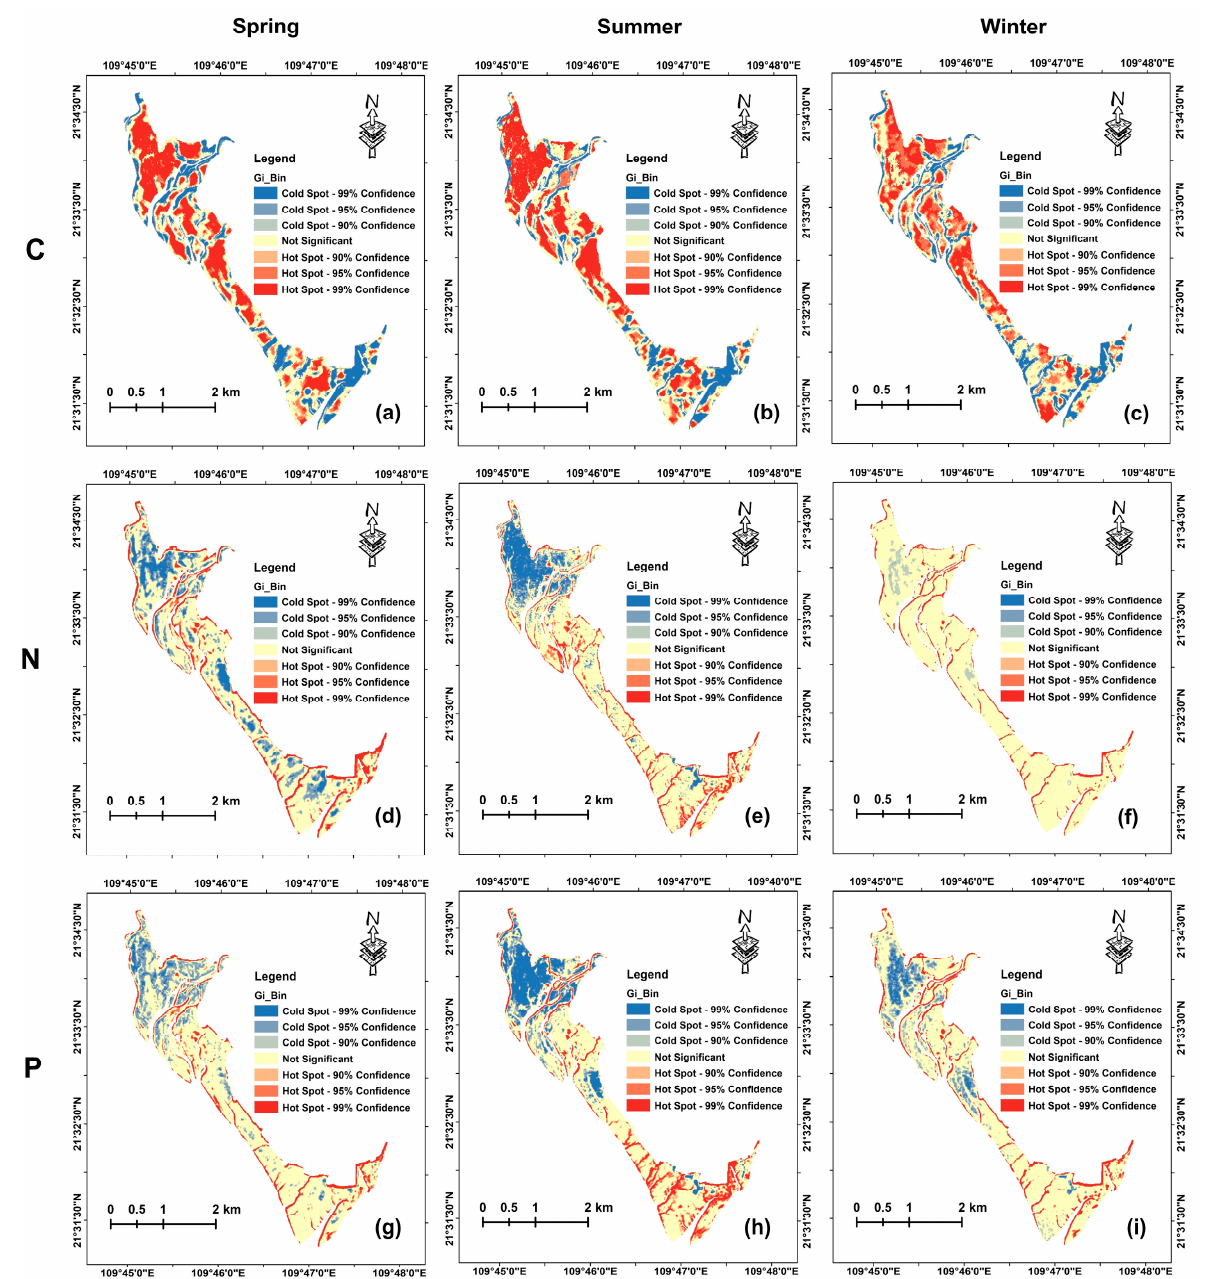
Figure 7. Hotspot analysis of mapped leaf C ( a – c ), N ( d – f ), and P ( g – i ) concentrations in spring, summer, and winter. 3.4.2. Mapping Seasonal Leaf C, N and P Concentrations from 2017 to